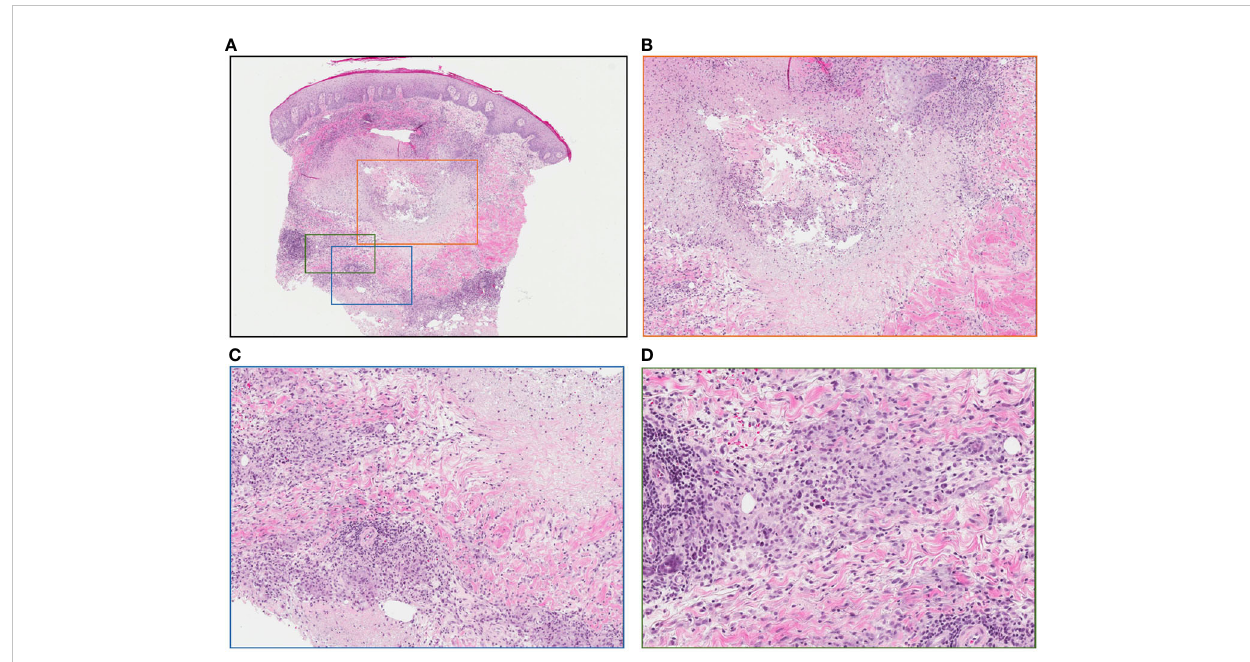
FIGURE 5 Punch biopsy of lesion following intralesional-IL-2 and BCG. (A) No evidence of residual melanoma, central necrosis and surrounding granulomatous reaction (low power) (B) Area of central necrosis (medium power) (C) Granulomatous reaction (medium power) (D) Granulomatous reaction (high